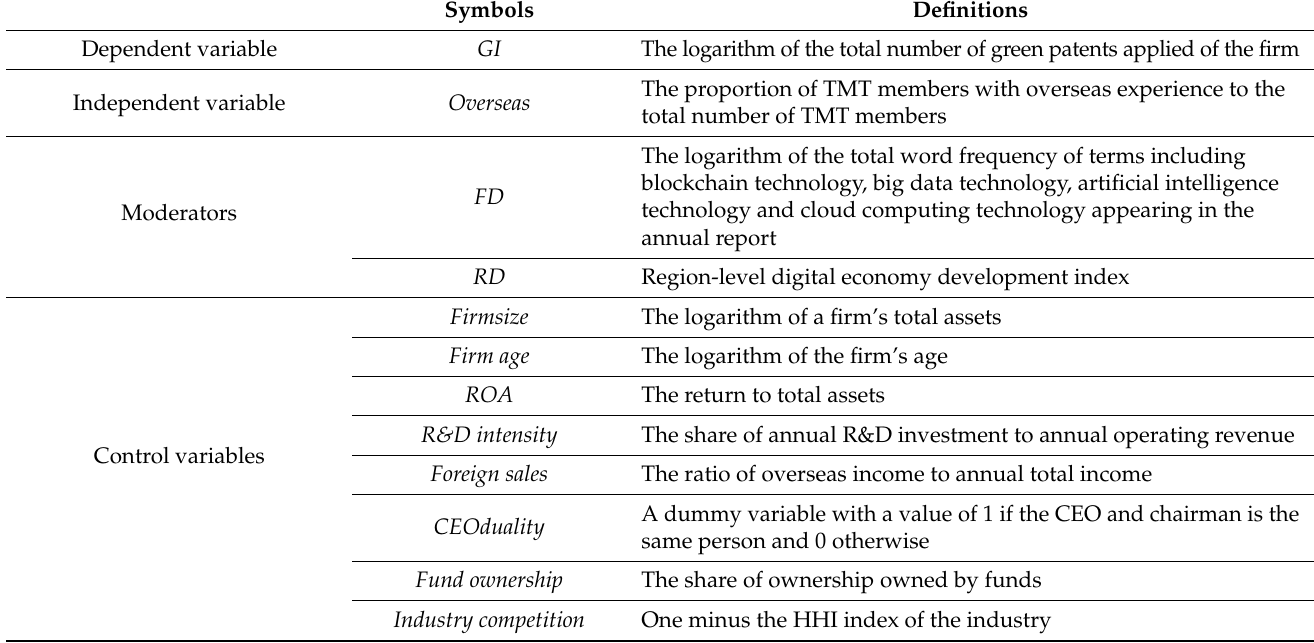
Table 1. Definitions of variables.